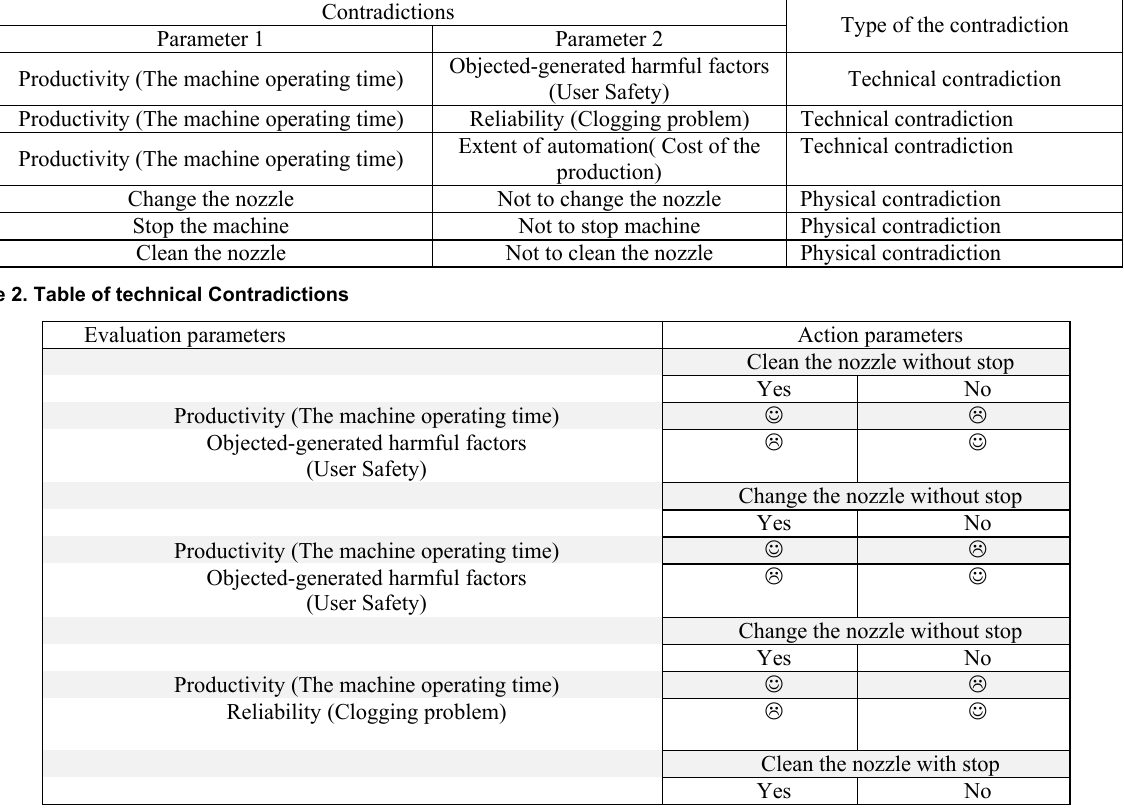
Figure 6. Problem graph of the clogging of the nozzle Table 1. The list of all possible contradictions related to the nozzle according to the TRIZ classification List of the possible contradictions related the nozzle